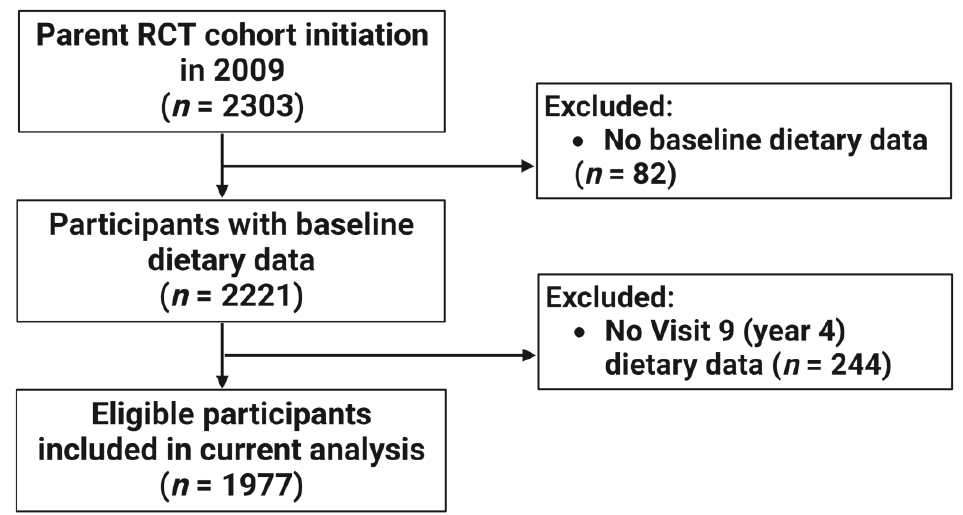
Figure 1. Flow diagram of participant inclusion.